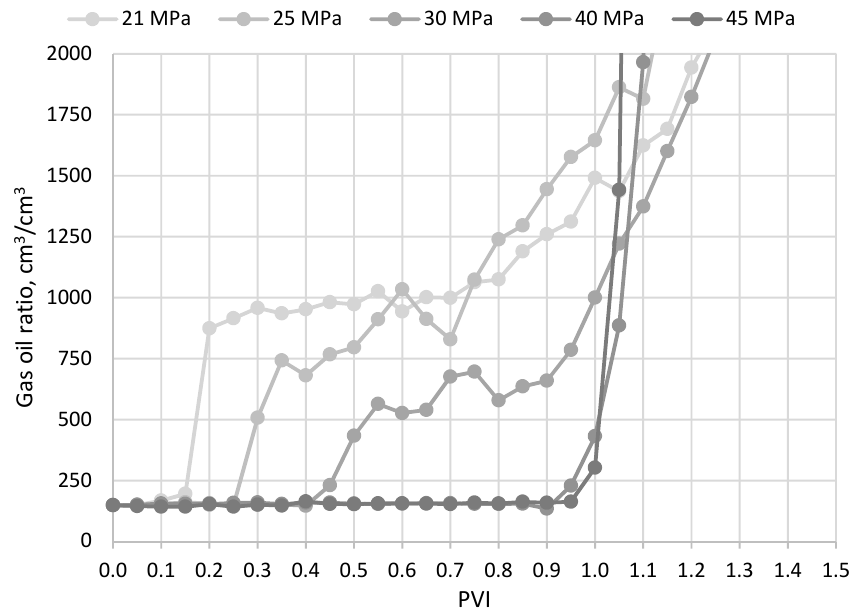
Figure 6. Gas–oil ratio dynamics for APG injection at pressures 21–45 MPa.